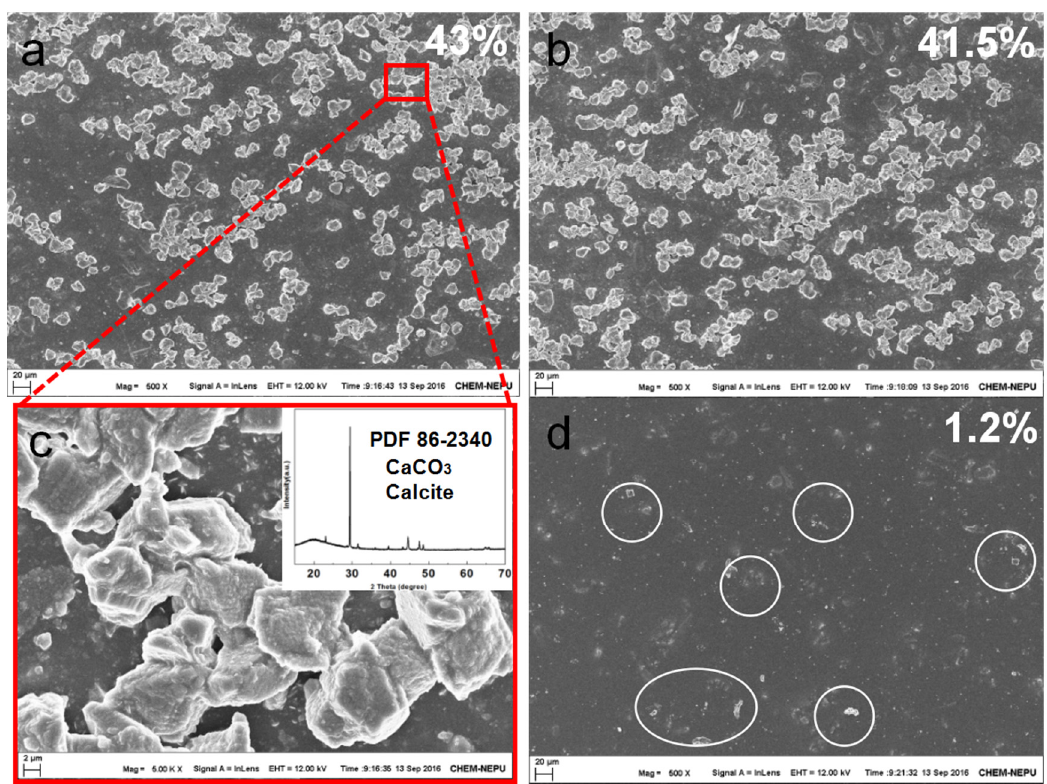
Figure 9. Scale inhibition property of ( a , c ) pure epoxy coating, ( b ) OTiO 2 (w) epoxy coating, and ( d ) iETiO 2 (w) epoxy coating.